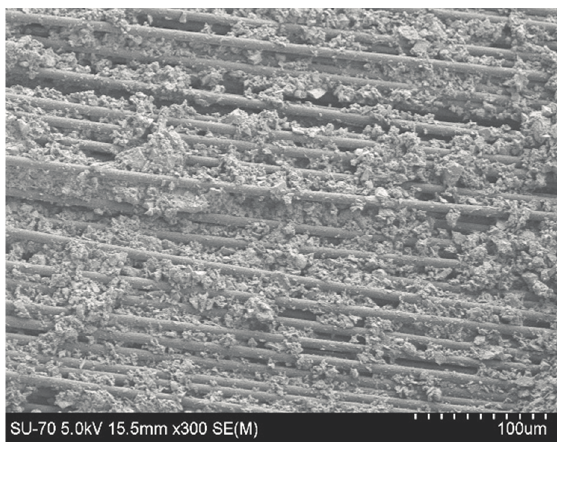
Figure 13. SEM of MPC-based FRIP